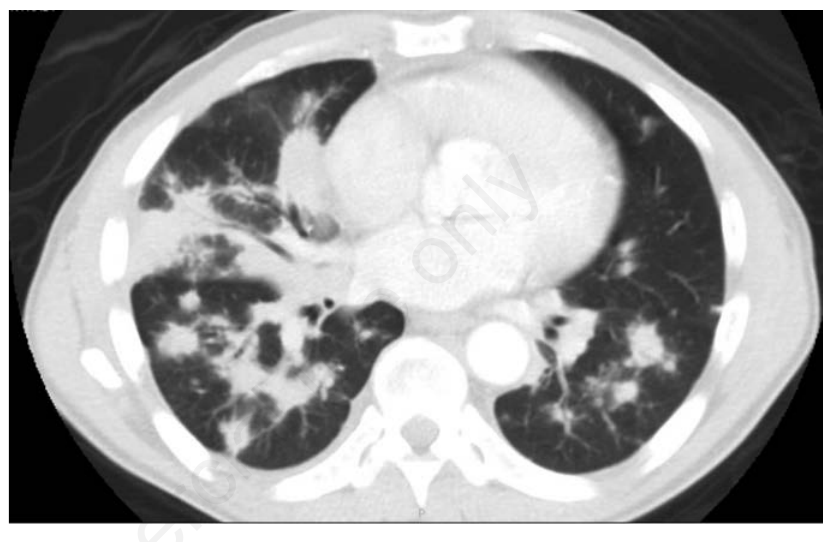
Figure 1. Computed tomography of the chest showing extensive diffuse irregular nodular and airspace opacities mainly affecting the right middle lobe.